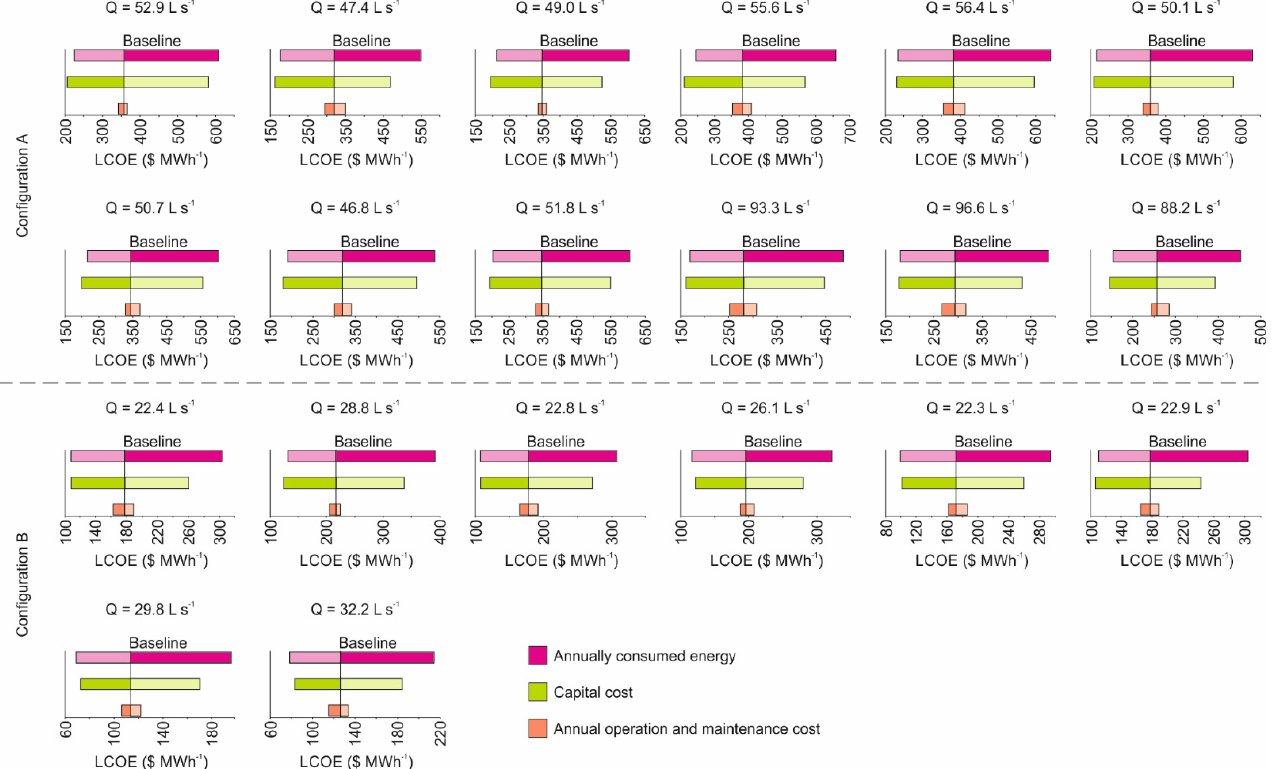
Figure 18. Input parameters ranked according to their influence on the levelized cost of energy. Baseline—overall simulated mean value, solid color—positive impact on the output, transparency—negative impact on the output. The cost is in USD. The reader is referred to Tables 4 and 5 for further details on the flow rates.